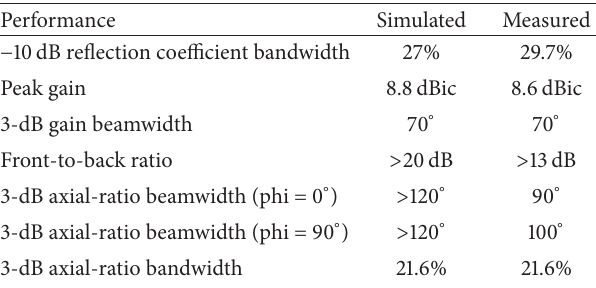
Table 2: Performances of the proposed antenna.